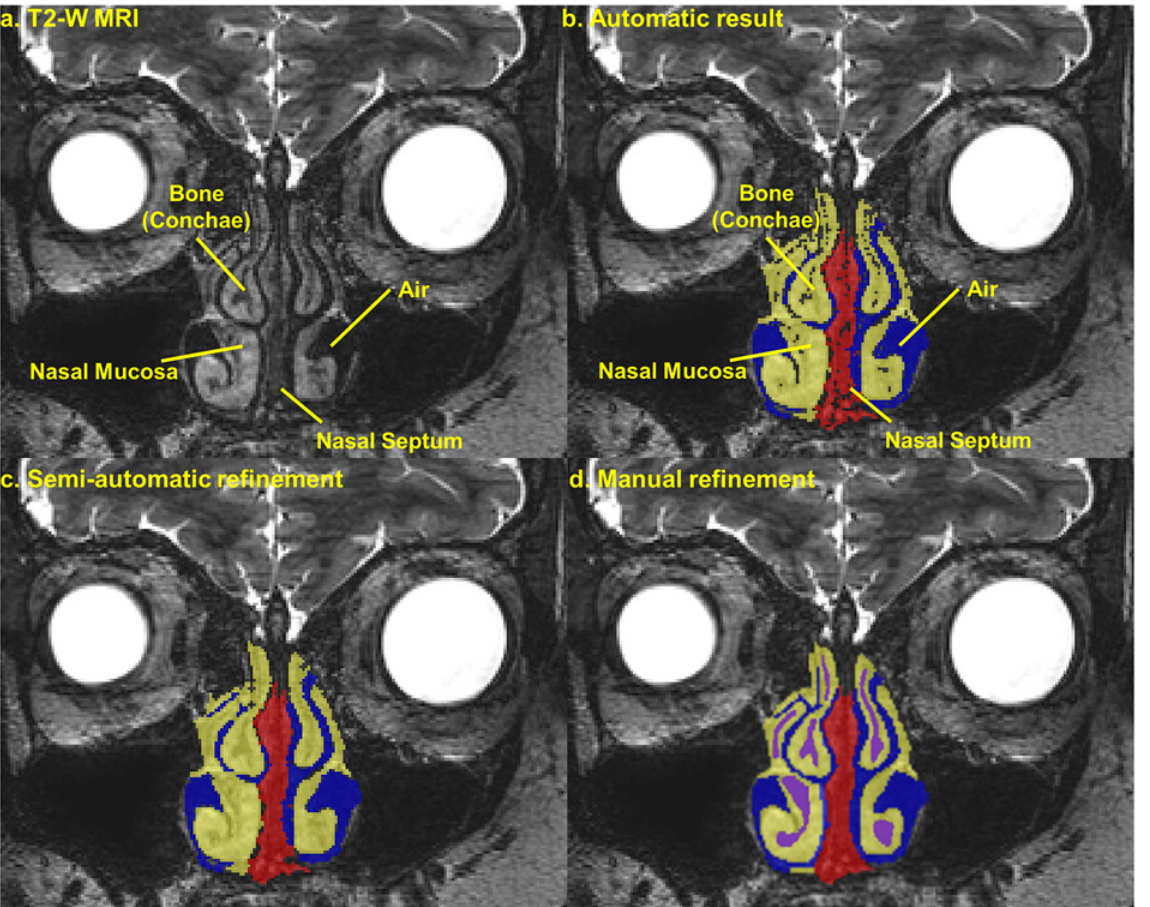
Fig 4. Segmentation procedure. (a) Coronal section of the T2-weighted MRI centered on the nasal region, (b) the result of the automatic segmentation of the nasal mucosa, nasal septum, and air cavity by means of a region growing technique (step ii), (c) the result of the segmentation after the application of semi-automatic smoothing algorithms (step iii), and (d) the final segmentation result after manual delineation of the bone (not captured automatically) and global manual refinement (step